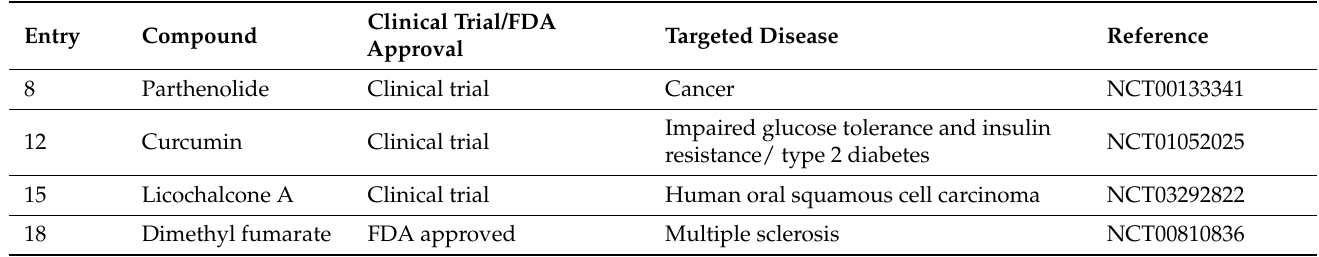
Table 2. α , β -unsaturated moiety-bearing NRF2 activators in clinical trial or approved by